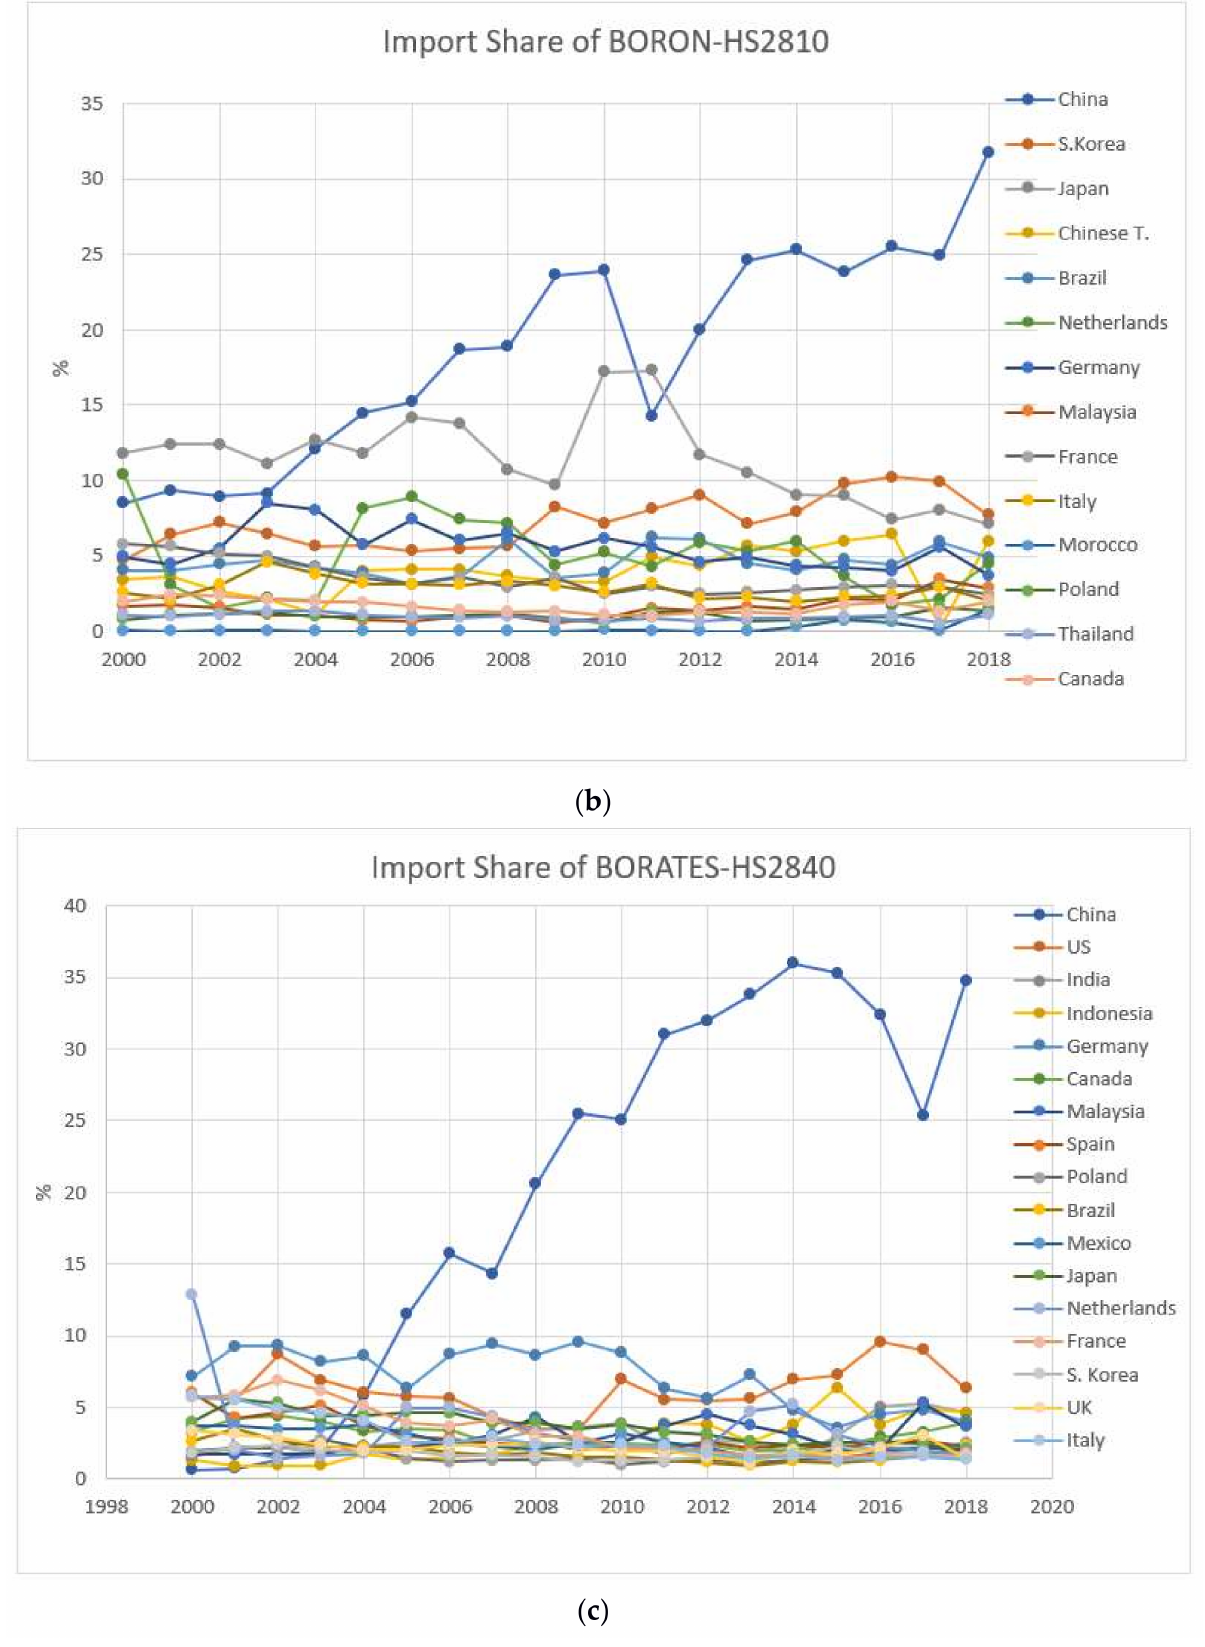
Figure 5. Boron products’ import share of countries. ( a ) Import Share of BORAX-HS2528 ( b ) Import Share of BORON-HS2810 ( c ) Import Share of